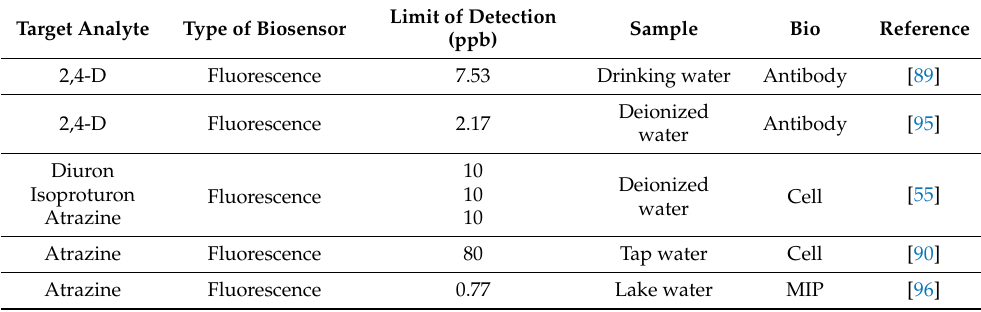
Table 2. Published work on detection of pesticides in water. Target Analyte